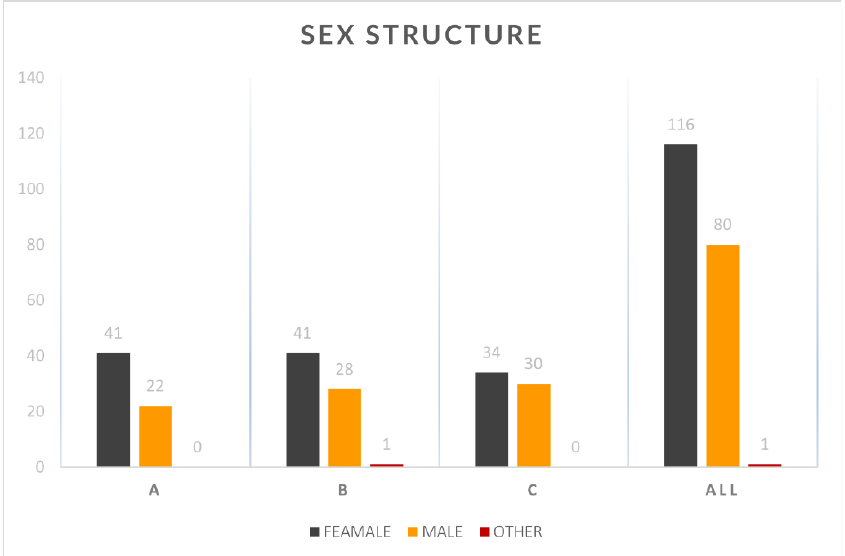
Figure 5. Sex distribution among participants.